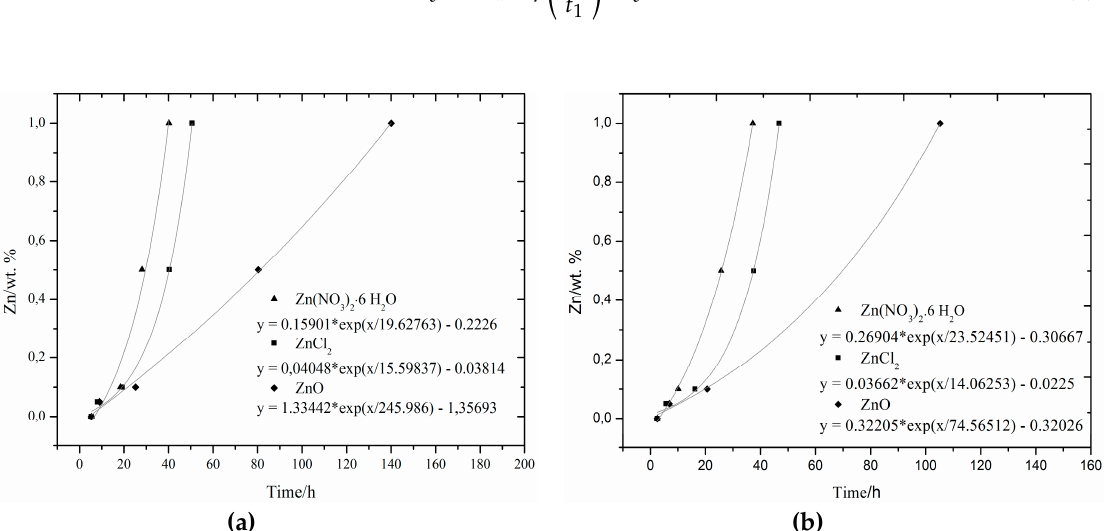
Figure 7. comparison of the lengths of induction periods for isoperibolic ( a ) and isothermal ( b ) calorimetry.